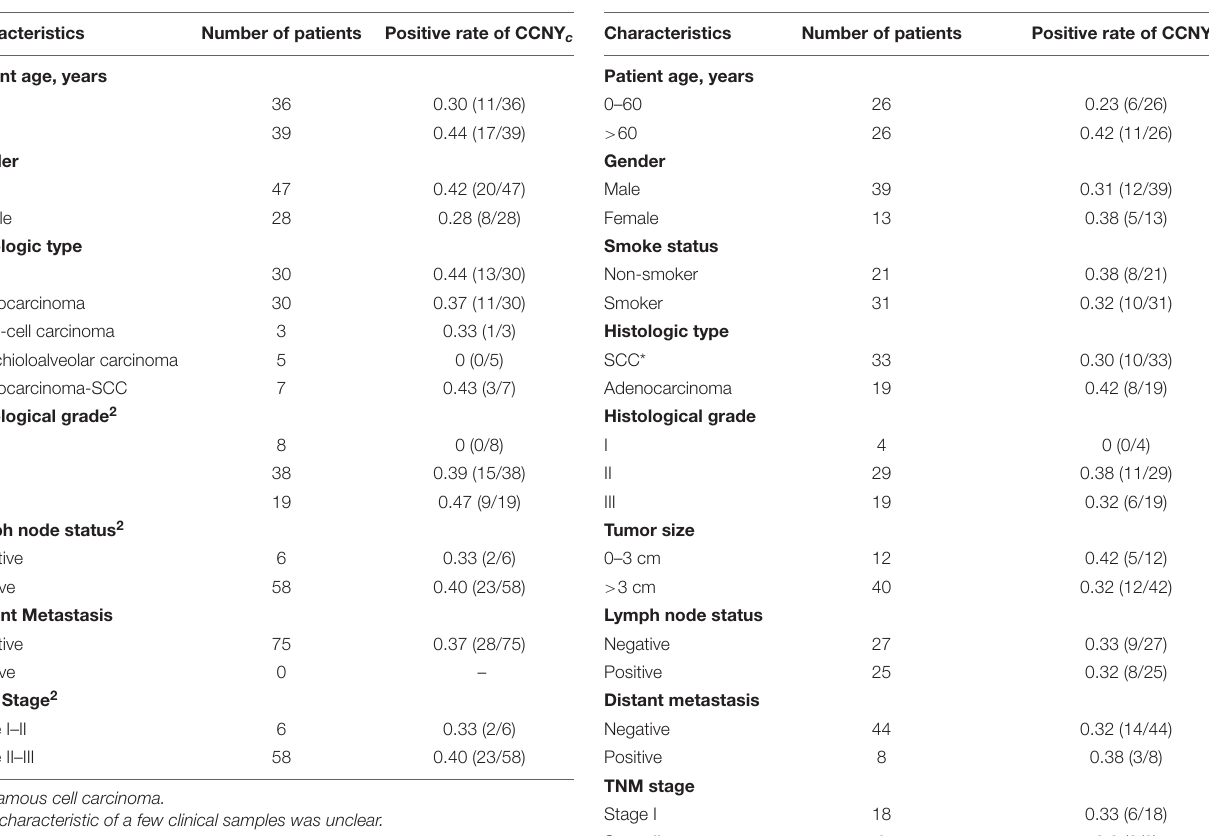
TABLE 1 | Clinical samples of tissue multi arrays. TABLE 2 | Patients and clinical